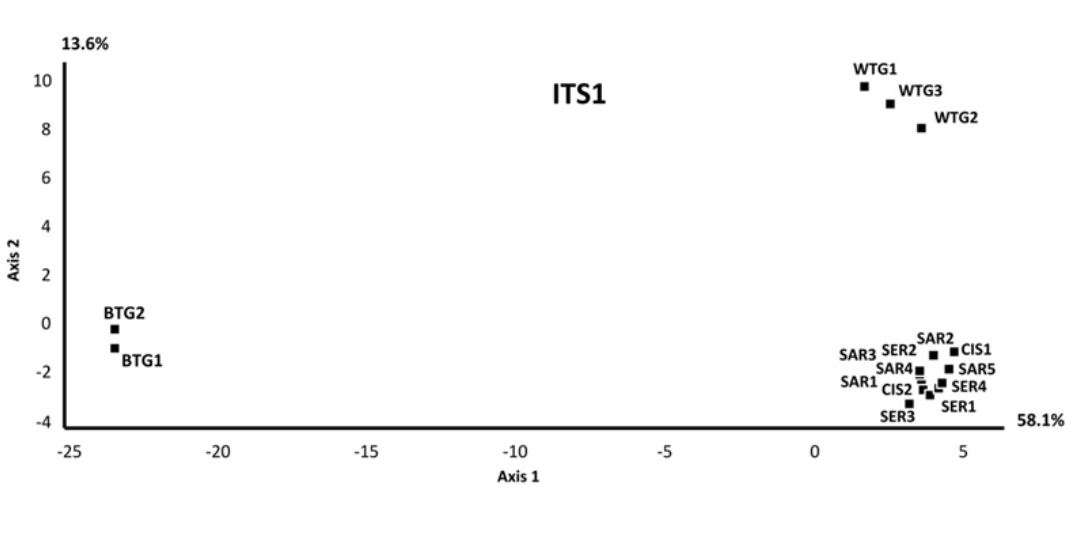
Figure 2. Principal Component Analysis of fungal assemblages in WTG (WTG 1-3), BTG (BTG 1-2), SAR (SAR 1-5), CIS (CIS 1-2) and SER (SER 1-4) soil samples, based on presence/absence data of ITS1 or ITS2 OTUs occurring in either all five soil sample groups or all samples within a group. Percentage variance values accounted for by the two first ordination axes are reported along each